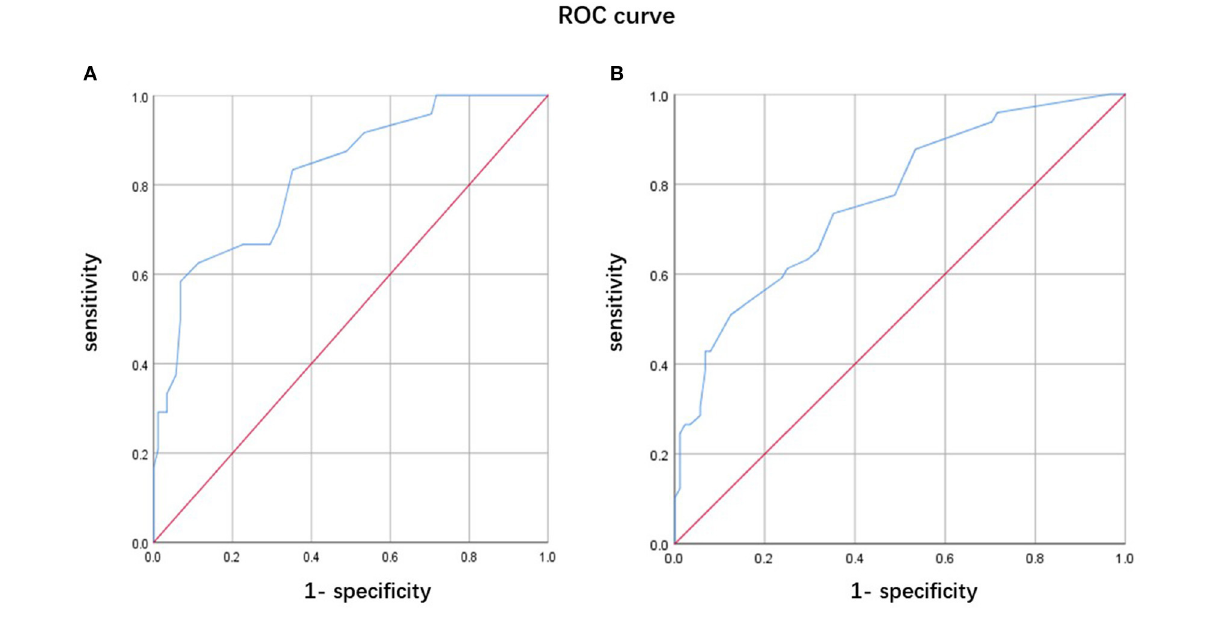
FIGURE 2 | Receiver operating characteristic curve of predicting psychotic symptoms in Parkinson’s disease (PD) patients. (A) A combination of the Hoehn-Yahr (H-Y) stage and FAB score for predicting complex minor hallucination (MH) occurrence in PD patients. (B) A combination of the H-Y stage and FAB score for predicting the MH occurrence in PD